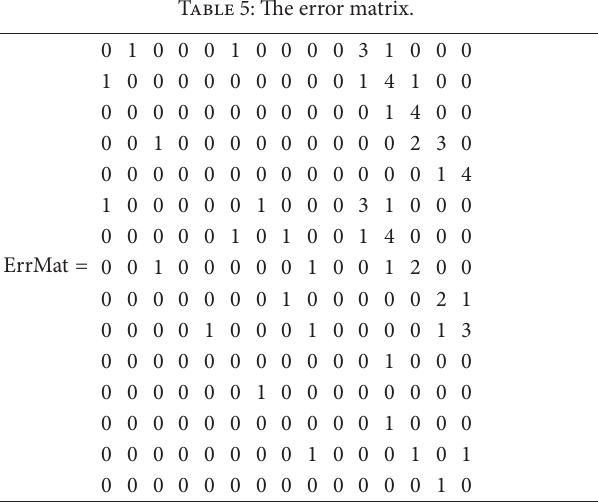
Table 5: The error matrix.